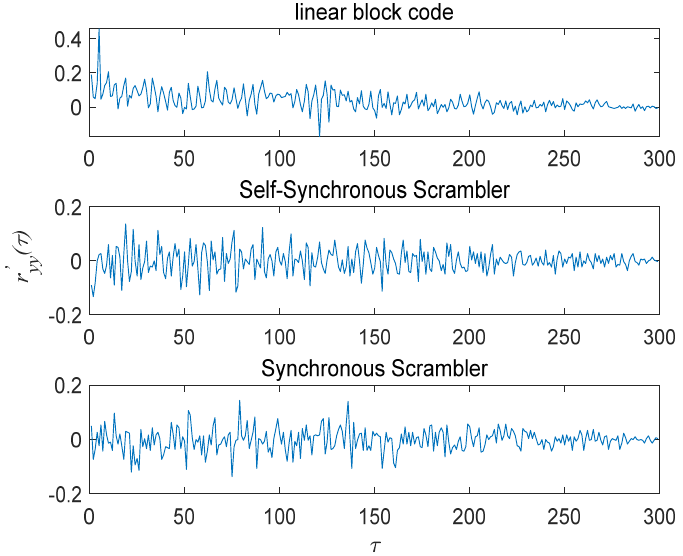
Figure 4. Normalized partial autocorrelation function diagram when BER = 0.1.